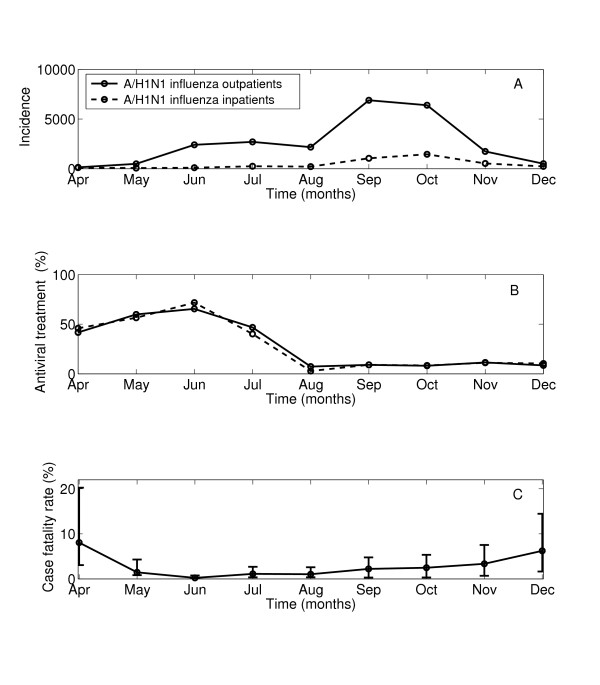
Temporal evolution of neuraminidase inhibitor administration rates and the case fatality ratio by date of symptoms onset during the 2009 A/H1N1 influenza pandemic in Mexico, AprilDecember 2009. A) Monthly number of new laboratory-confirmed A/H1N1 influenza outpatients and inpatients, B) Monthly percentage of laboratory-confirmed A/H1N1 influenza outpatients and A/H1N1 inpatients that received antiviral medications during the pandemic period, and C) the monthly case fatality ratio (and corresponding 95% CIs) based on all A/H1N1 influenza cases during the pandemic period.